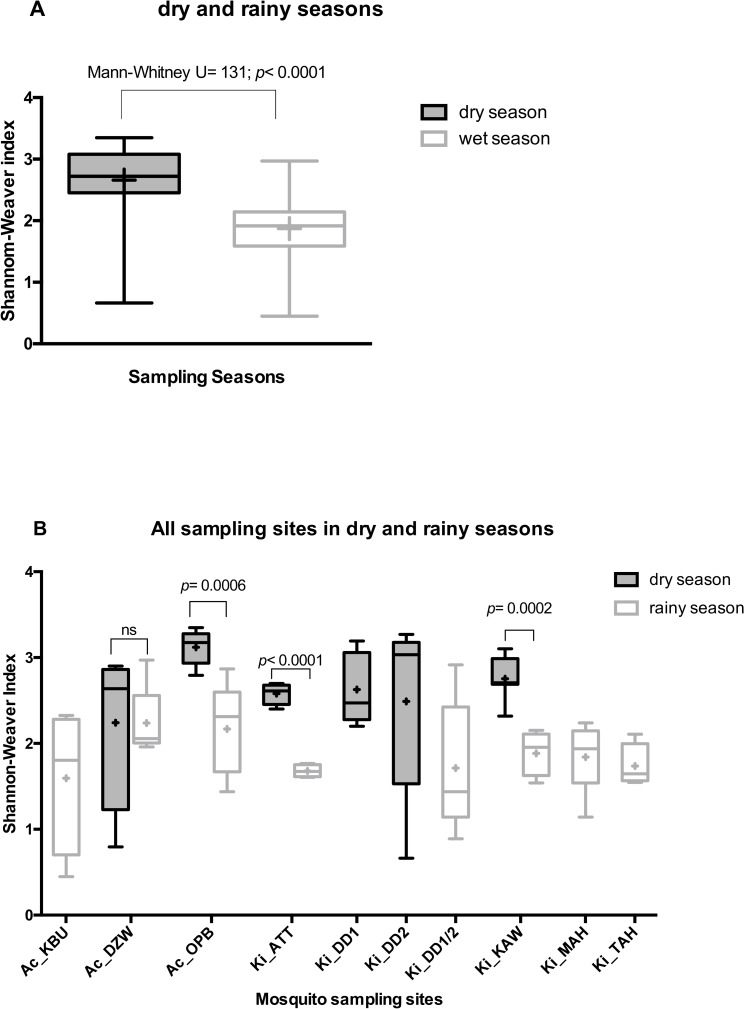
Shannon-Weaver indices compared among samples collected in dry and rainy season.Crosses in the box indicate the mean, and black lines are medians.